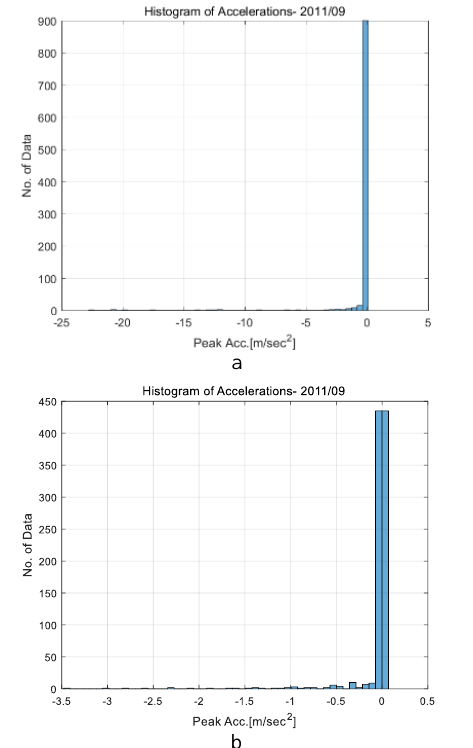
Figure 5. Histogram of peak accelerations (September 2011): a. raw signals and b. signals within 95% confidence